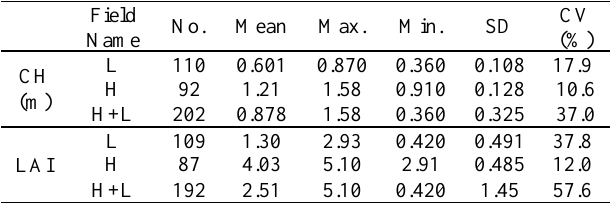
Table 1 Descriptive statistics of field-measured canopy height (CH) and leaf area index (LAI).